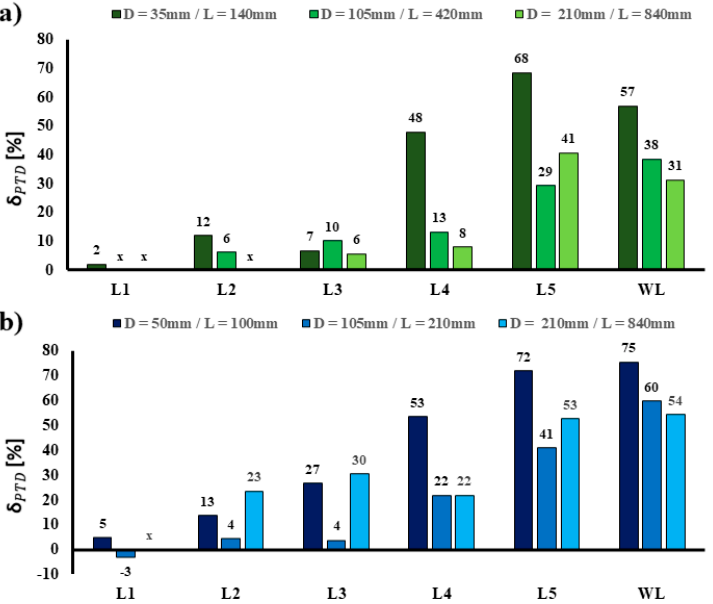
Figure 12. The relative differences between the photometric test distances obtained as a result of the calculations and the measurements: ( a )—for the linear LED luminaire, ( b )—for the surface LED luminaire.